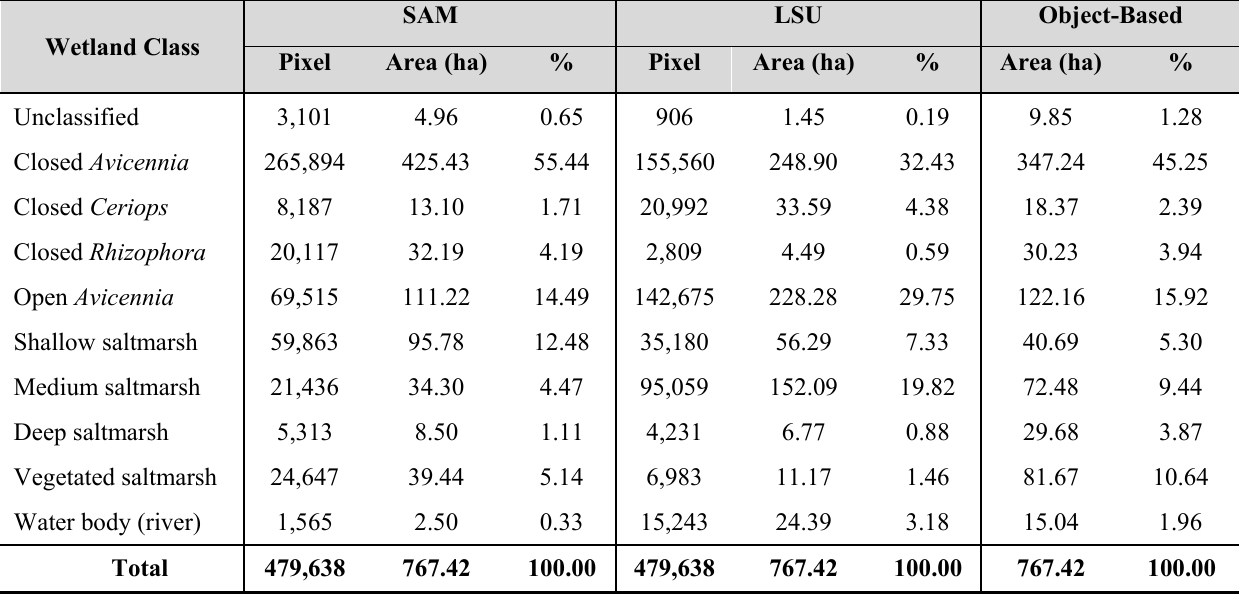
Table 2. Summary statistics of the wetland classes for all classified map.